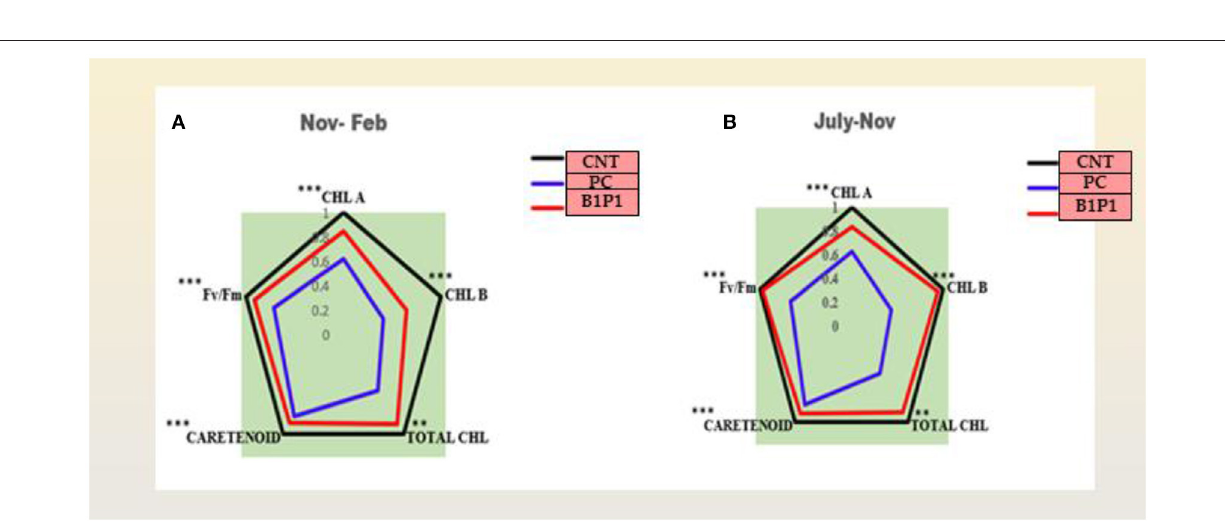
Frontiers in Fungal Biology |